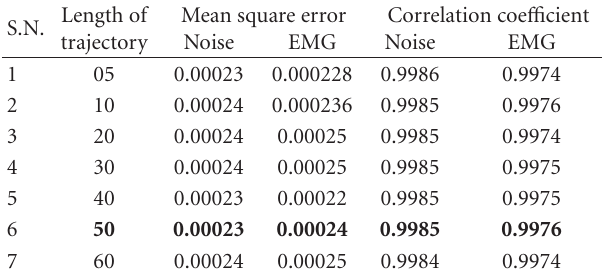
Table 8: Selection of length of trajectory for optimal performance of FTLRNN model.